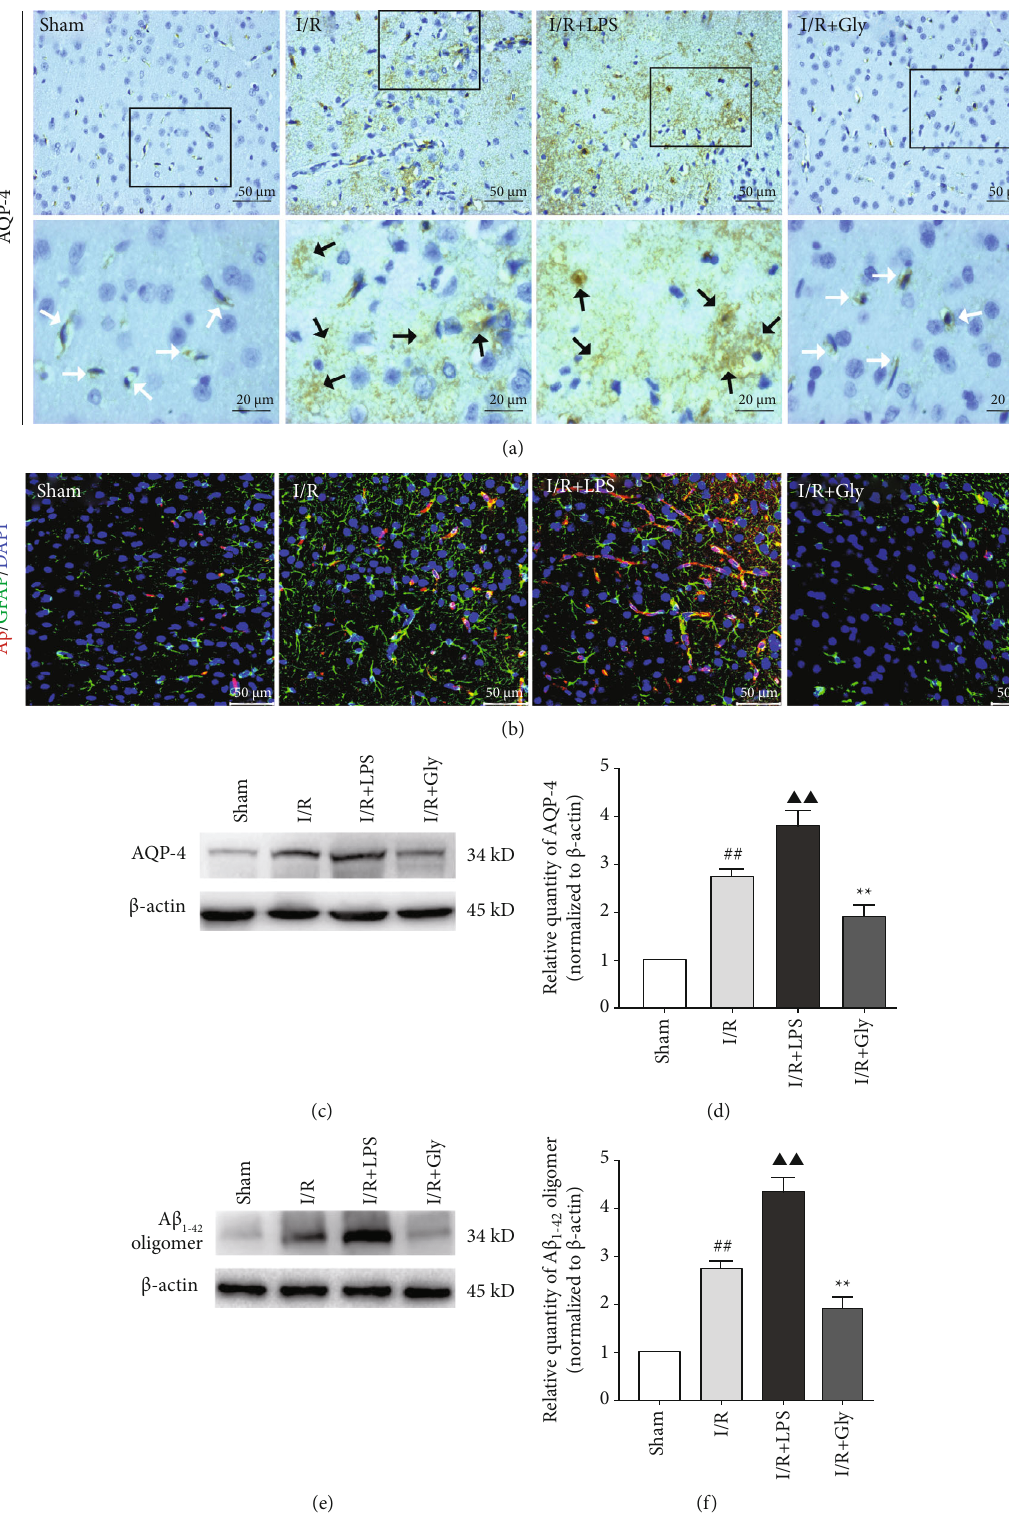
Figure 5: In fl uences of pyroptosis on AQP-4 polarization and A β clearance at 24 h after reperfusion. (a) Representative pictures of immunohistochemical staining of AQP-4. White arrows represent normal AQP-4 polarization, and black arrows represent the loss of AQP-4 polarization with obvious dispersion and perturbed expression, scale bars, 50/20 μ m. (b) Representative pictures of double immuno fl uorescence staining of A β (red) colocalized with GFAP (green), scale bars, 50 μ m. (c, d) Protein levels of AQP-4 by Western blotting analysis, n = 6 . (e, f) Protein levels of A β oligomer by Western blotting analysis, n = 6 . Data are presented as mean ± SD . 1-42 ## P < 0 : 01 , I/R group versus sham group; ▲▲ P < 0 : 01 , I/R +LPS group versus I/R group; ∗∗ P < 0 : 01 , I/R + Gly group versus I/R